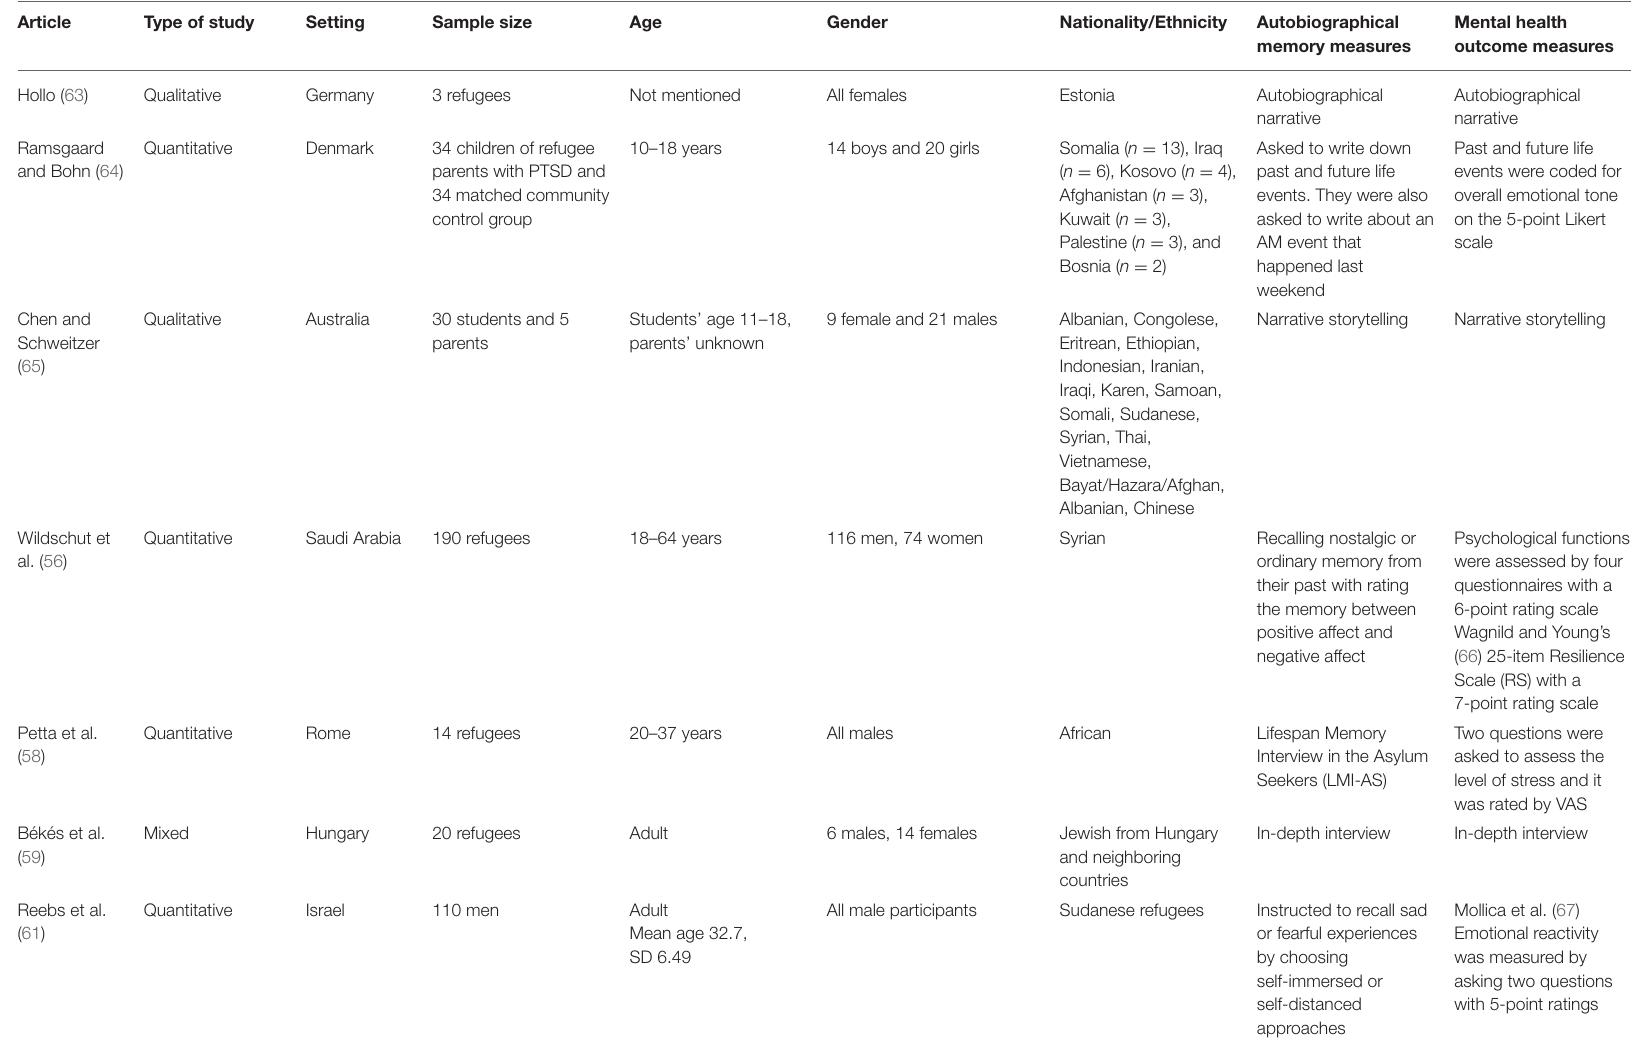
TABLE 1 | Summary of the articles selected for the